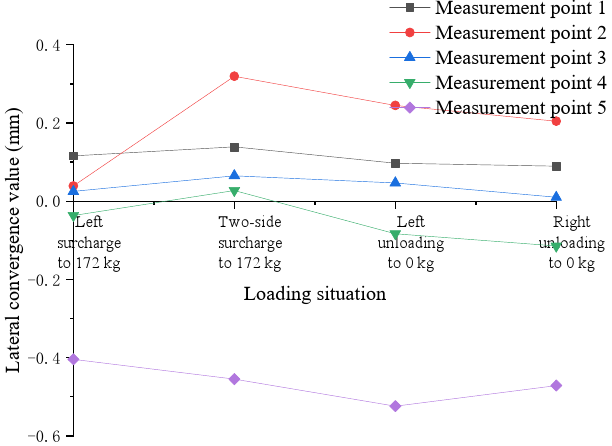
Figure 16. Variation in the lateral convergence of each measurement point in the tunnel under different surcharge conditions for Case 4.